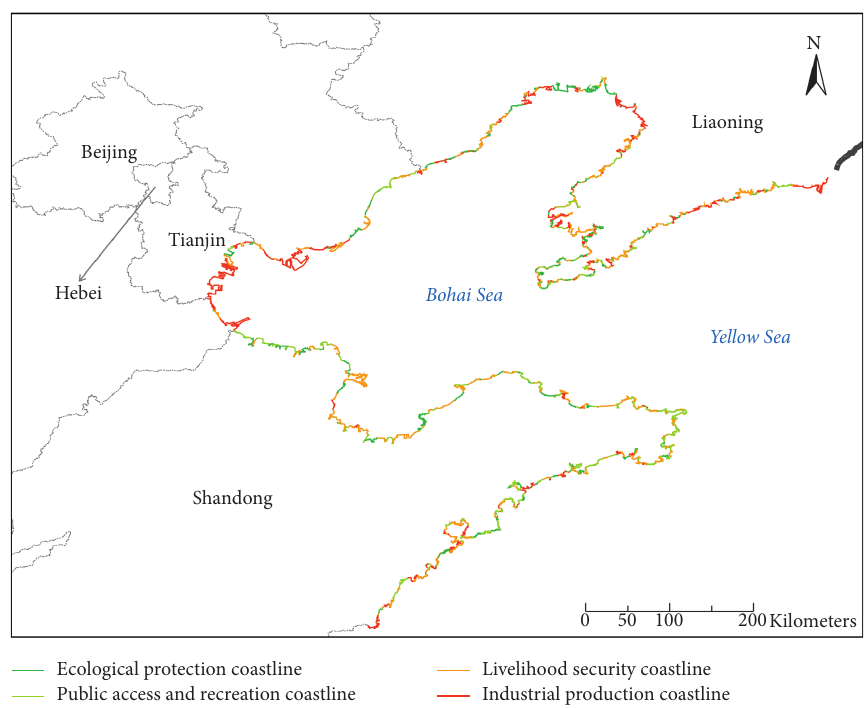
Figure 3: Spatial distribution of comprehensive coastline utilization types at the Bohai